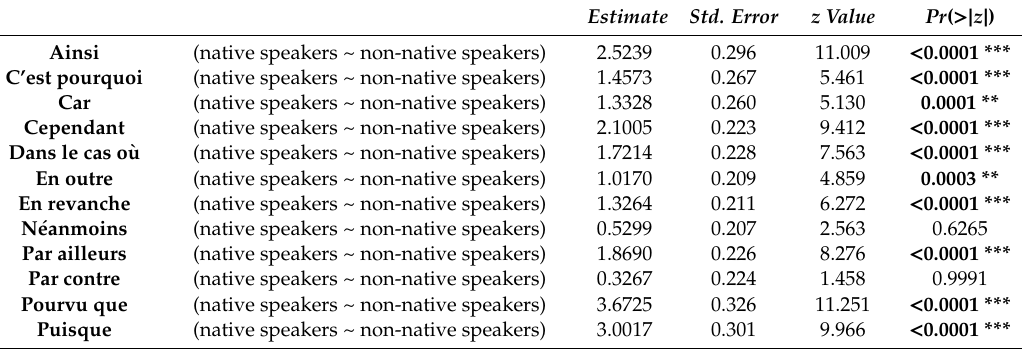
Table 6. Frequency: comparison of main task scores by native and non-native speakers. Estimate Std. Error